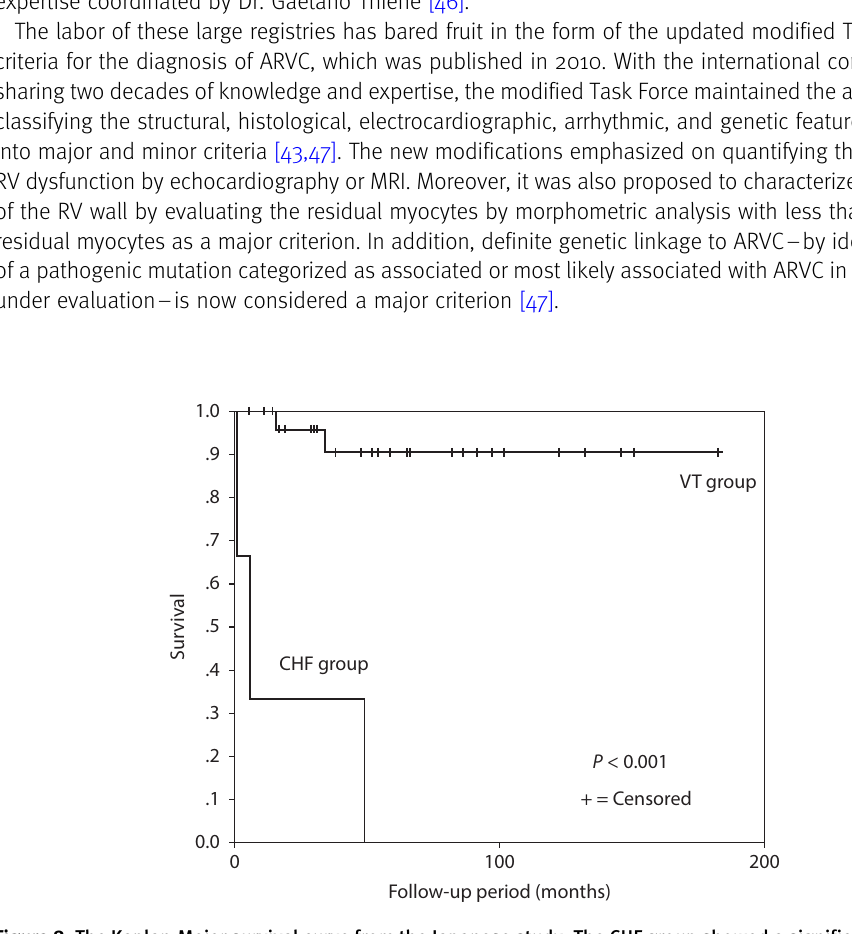
Figure 8. The Kaplan-Meier survival curve from the Japanese study. The CHF group showed a significantly higher mortality rate in comparison to the VT group